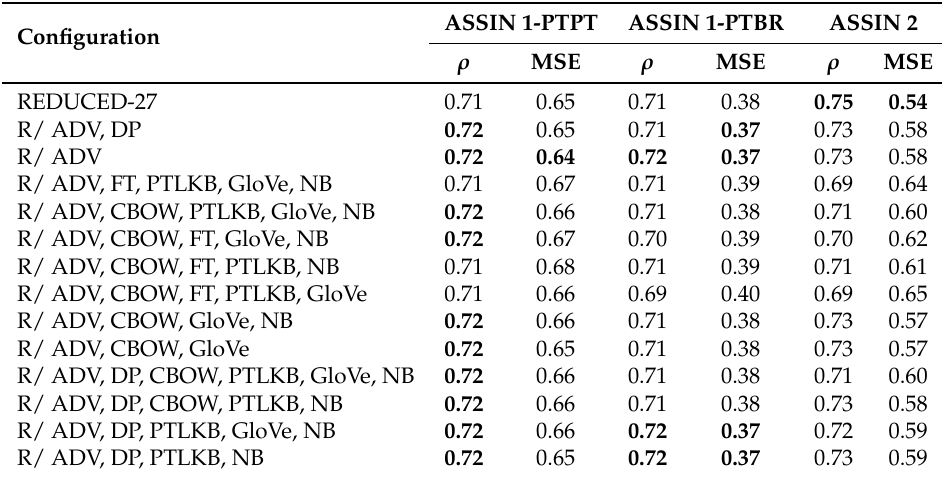
Table 8. Performance of the STS model on ASSIN and ASSIN-2 collections, when additional features are